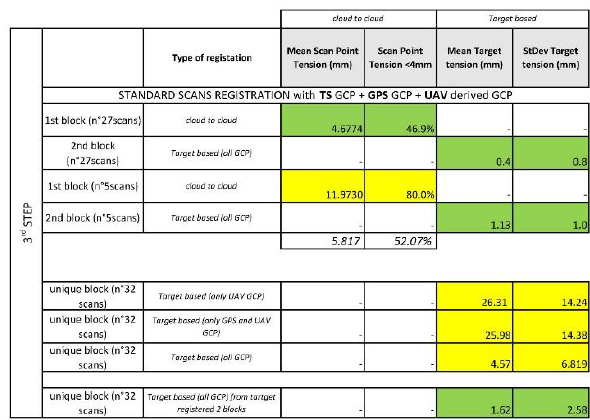
Figure 14. Accuracy results after additional constrains in clouds registration: 3° STEP